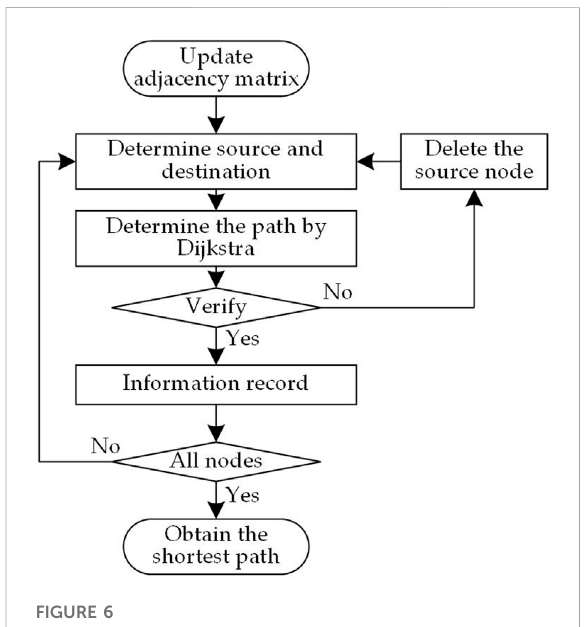
FIGURE 6 Flow chart of the decision making of restoration path.